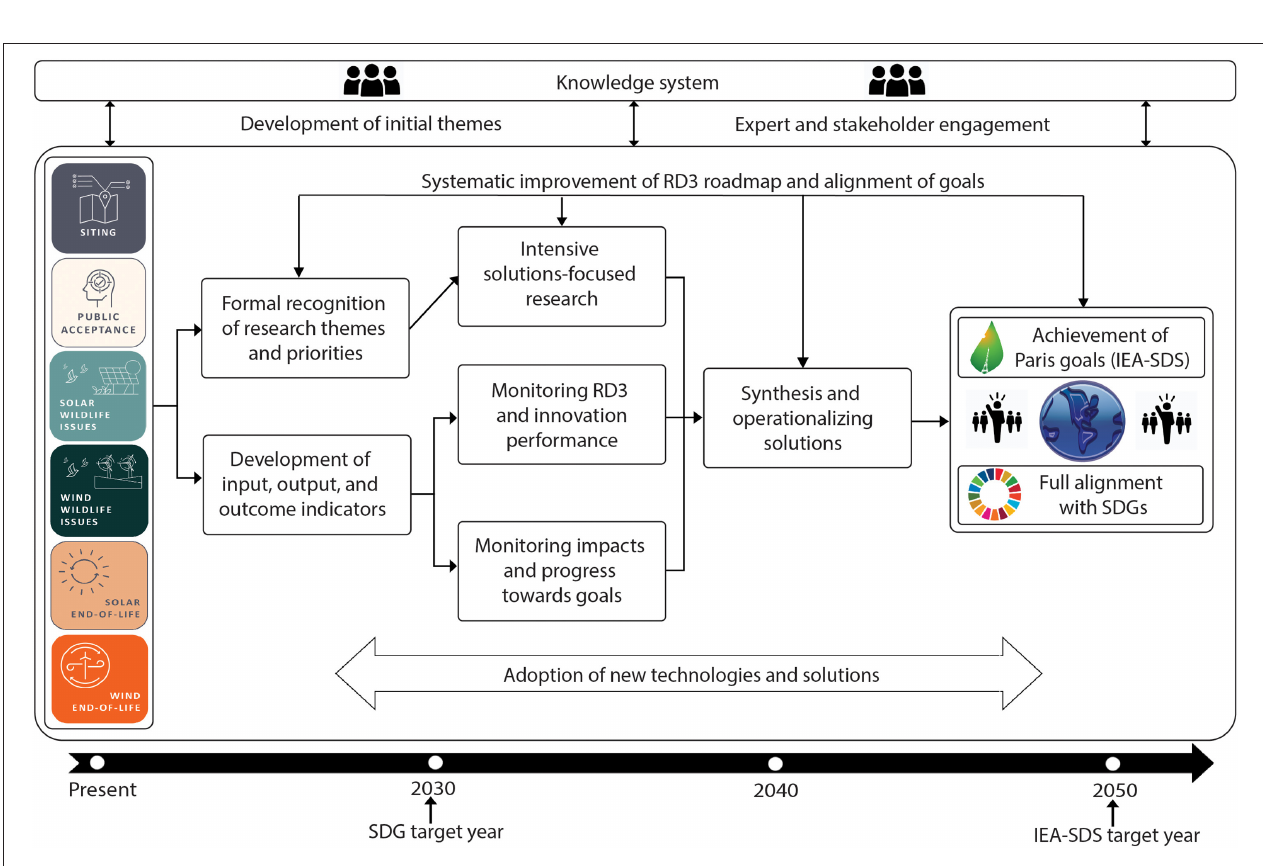
FIGURE 6 | A RD3 roadmap for ensuring climate goals and UN Sustainable Development Goals (SDGs) are met simultaneously for solar and wind energy. The roadmap encompasses not only research, development, and demonstration but also deployment (i.e., RD3) to ensure solutions are being systematically adopted throughout the duration of roadmap implementation. The International Energy Agency’s Sustainable Development Scenario (IEA-SDS) is used as an illustrative example for meeting climate goals in alignment with SDGs. Graphics use icons reproduced from the Noun Project (https://thenounproject.com).